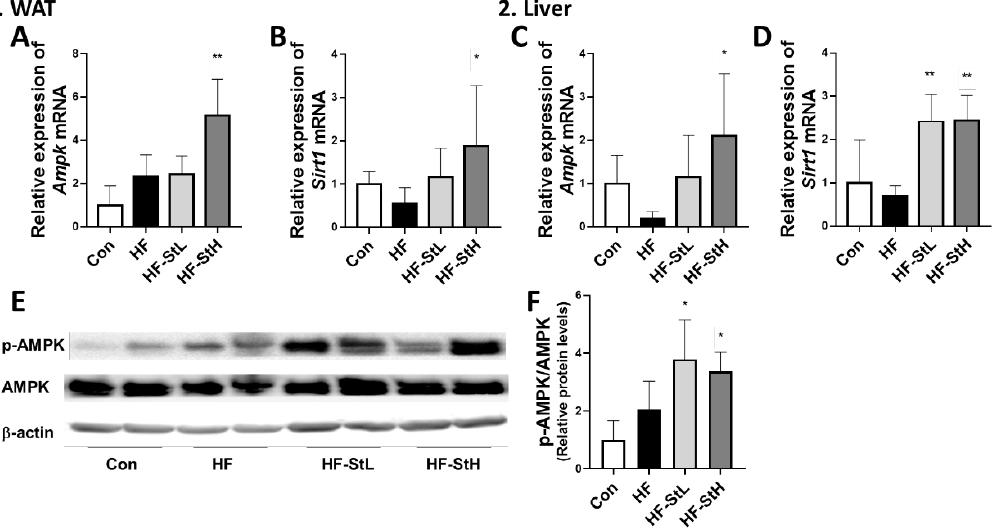
Figure 7. Effects of S. thunbergii (ST) extract on Ampk/Sirt1 pathway in white adipose tissue (WAT) and liver. ( A ) Ampk and ( B ) Sirt1 mRNA expressions in WAT. ( C ) Ampk and ( D ) Sirt1 mRNA expressions in liver. ( E ) Protein expressions of p-AMPK, AMPK, and β -actin in liver tissue. ( F ) Ratios of p-AMPK/AMPK. Con: chow diet, HF: high-fat diet, HF-StL: high-fat diet+ST extract 150 mg/kg bw, HF-StH: high-fat diet+ST extract 300 mg/kg bw. All data are presented as means ± SD (n = 10). Compared with the high-fat diet group, * p < 0.05, ** p < 0.01 by one way ANOVA followed by Dunnett’s test.